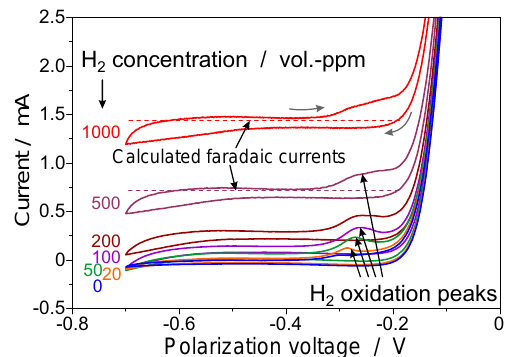
Figure 9. Voltammograms for measuring gases at different O 2 concentrations; potential scan rate: 200mVs − 1 ; electrode size: 7.5cm 2 ; open-circuit potential: − 241mV (5vol.ppm O 2 ) to − 135mV (500vol.ppm O 2 ); gas flow rate: 10sccm; cell temper- ature: 750 ◦ C; the second cycle is